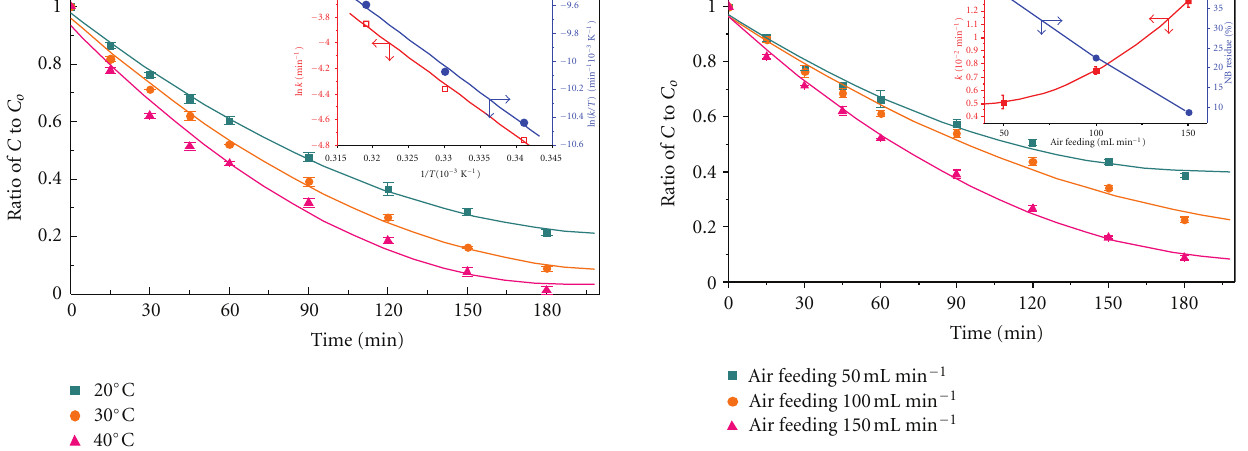
Figure 5: The temperature dependence of nitrobenzene photode- graded by TiO 2 as time changes. The processes were operated with 0.2g TiO 2 and 0.407 mM nitrobenzene at pH 7 and 20 ◦ C, 30 ◦ C, 40 ◦ C with the air feeding of 150 mLmin − 1 for 3 h. Inset shows the linear fits of the data for ln k and ln( k/T ) versus the reciprocal of temperature.